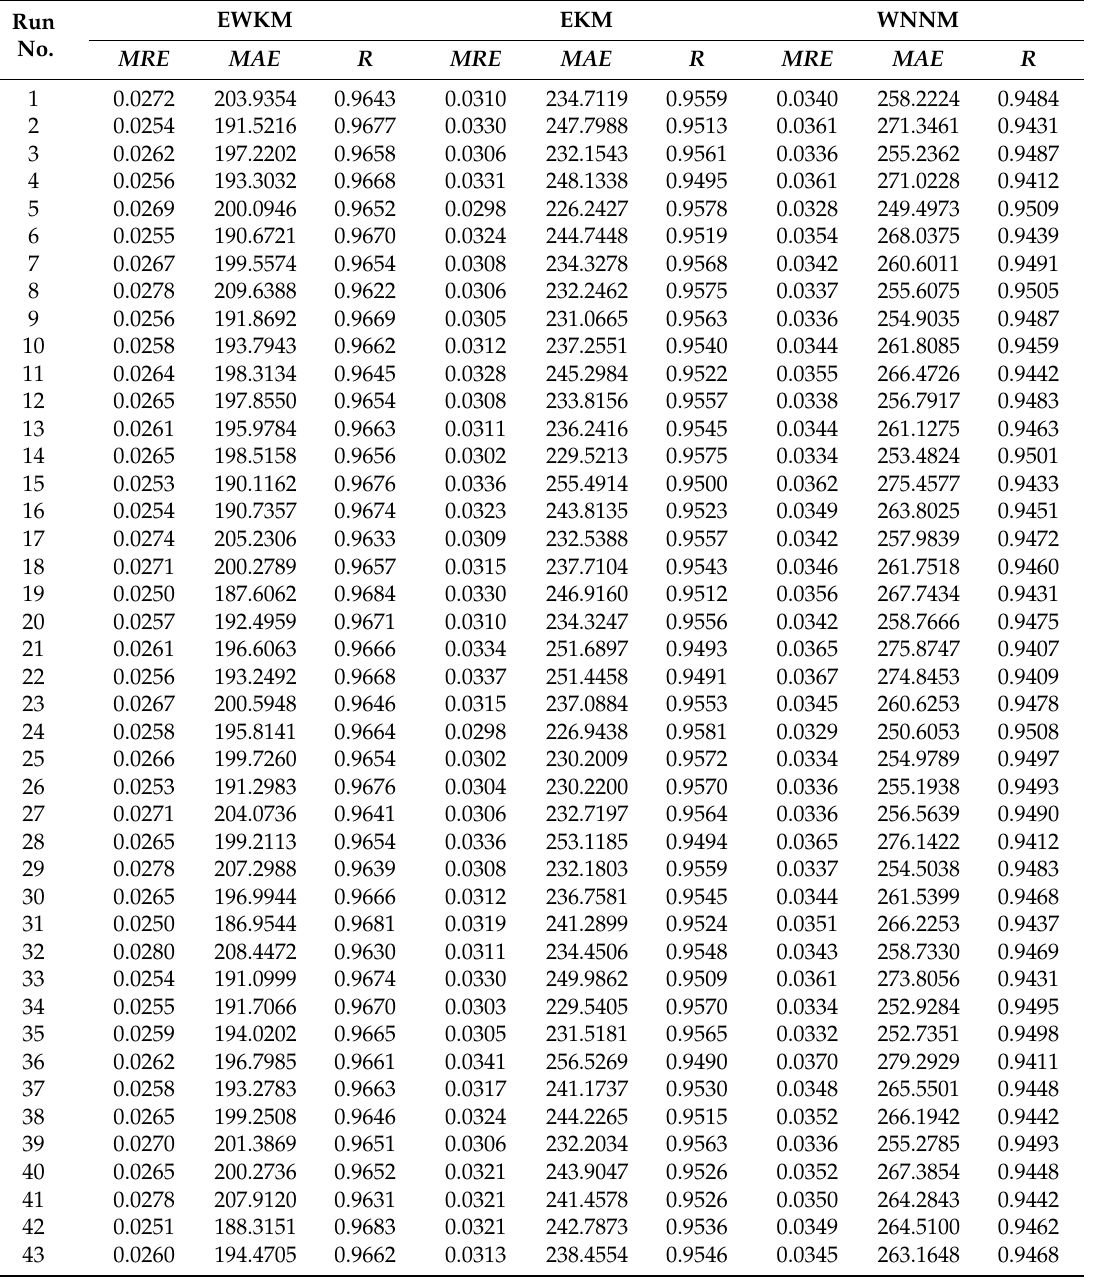
Table 4. The performance of the EWKM model compared to EKM and